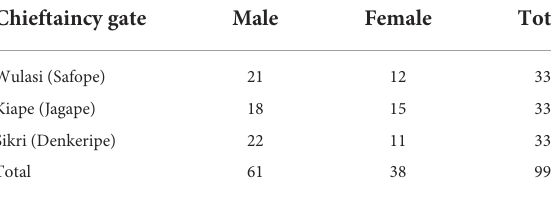
TABLE 2 Categories of respondents of participants’ perception survey. Chieftaincy